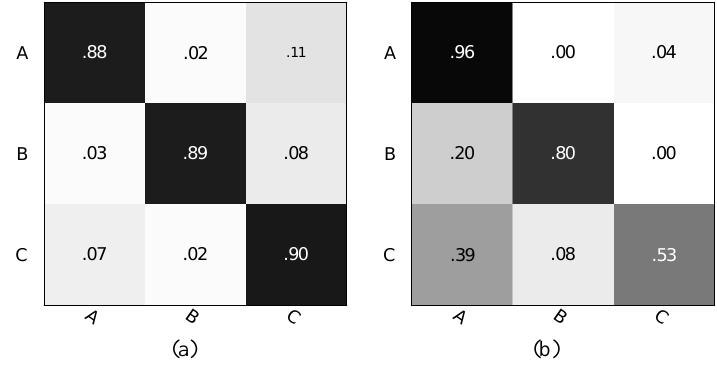
Figure 13. The confusion matrix for the roundabout dataset. ( a ) Causal grouping; ( b ) K-means